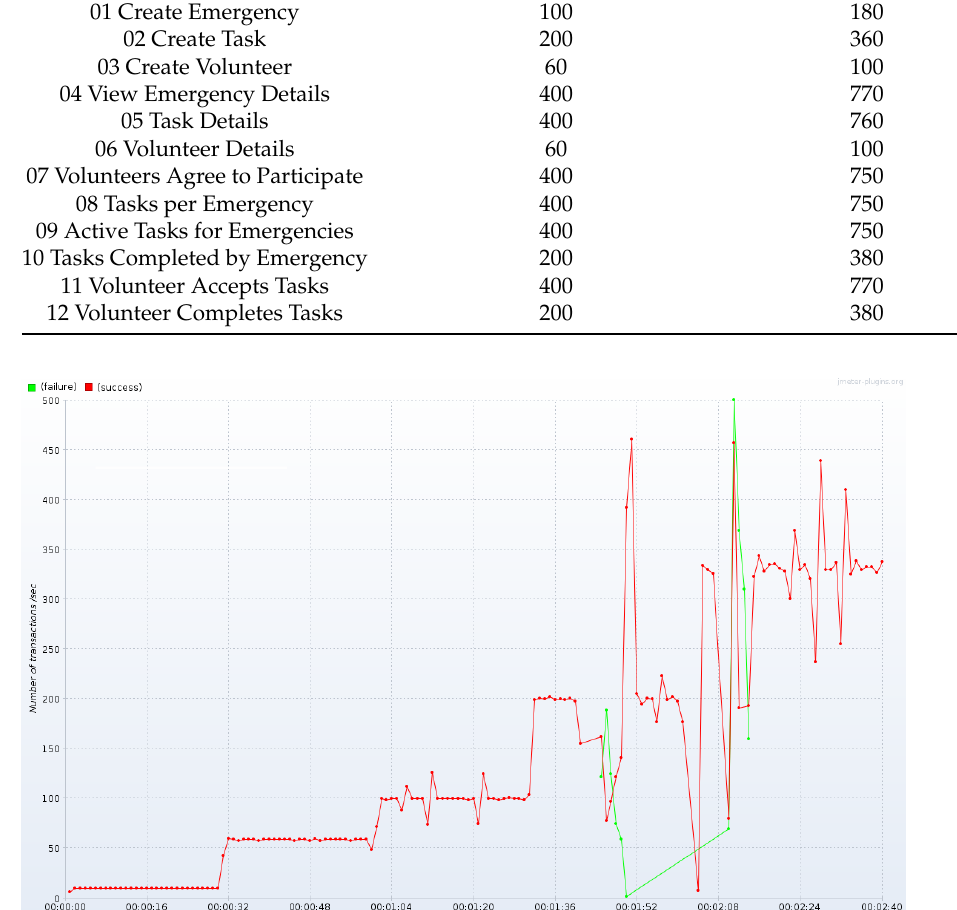
Figure 11. Single processor: Results obtained by the task “10—Tasks Completed by Emergency” on a single processor. The red line represents requests successfully completed. The green line represents requests not